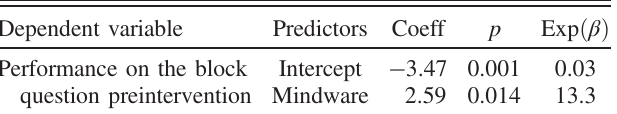
TABLE II. The results of logistic regression models that link student preintervention performance on the magnet question and the presence of mindware (as measured by the performance on the block